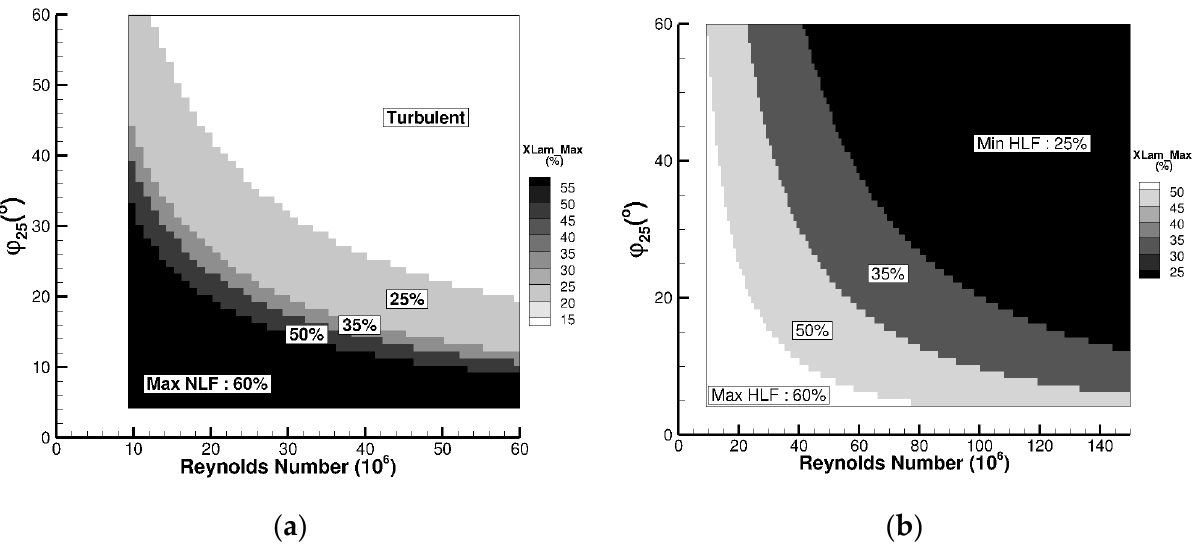
Figure 10. Maximum possible laminar flow extent as a function of Reynolds number and wing sweep angle. ( a ) NLF. ( b ) HLF.